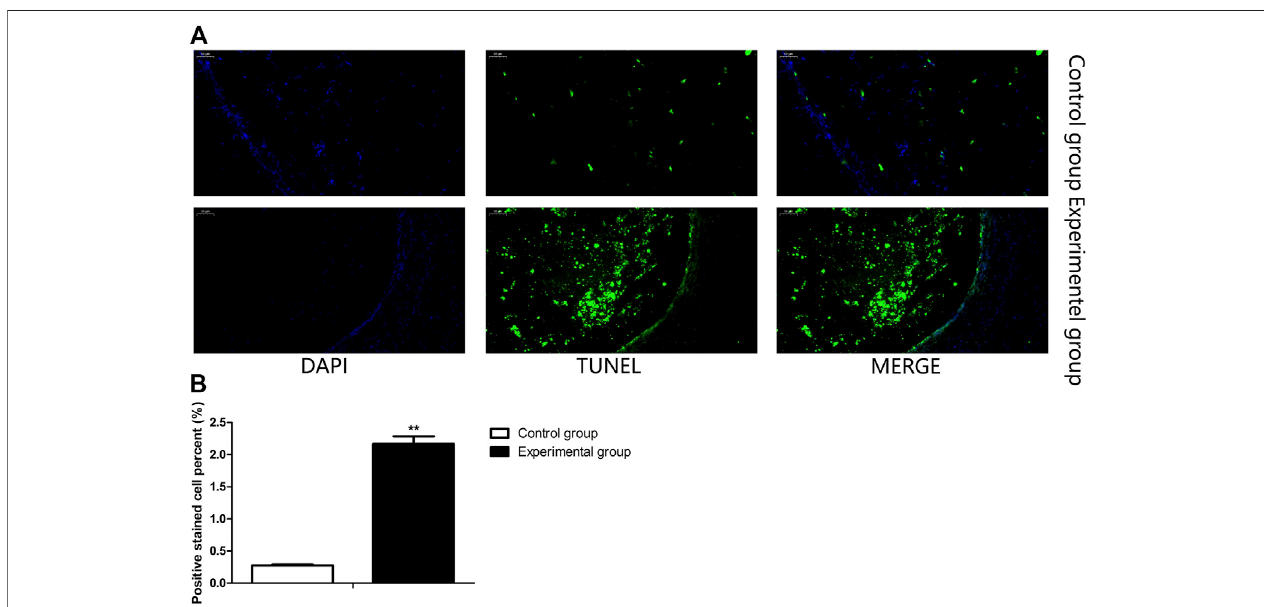
FIGURE 2 | Coprophagy prevention increased cell apoptosis in ovary of rabbits. (A) Representative images of ovarian stained by TUNEL assay, cell nuclei were stained by DAPI (blue), apoptotic cells were stained with TUNEL (green). (B) Quanti fi cation of the proportion of ovarian apoptotic cells as detected by TUNEL assay in each group of rabbits. Scale bar = 50 μ m ** p <